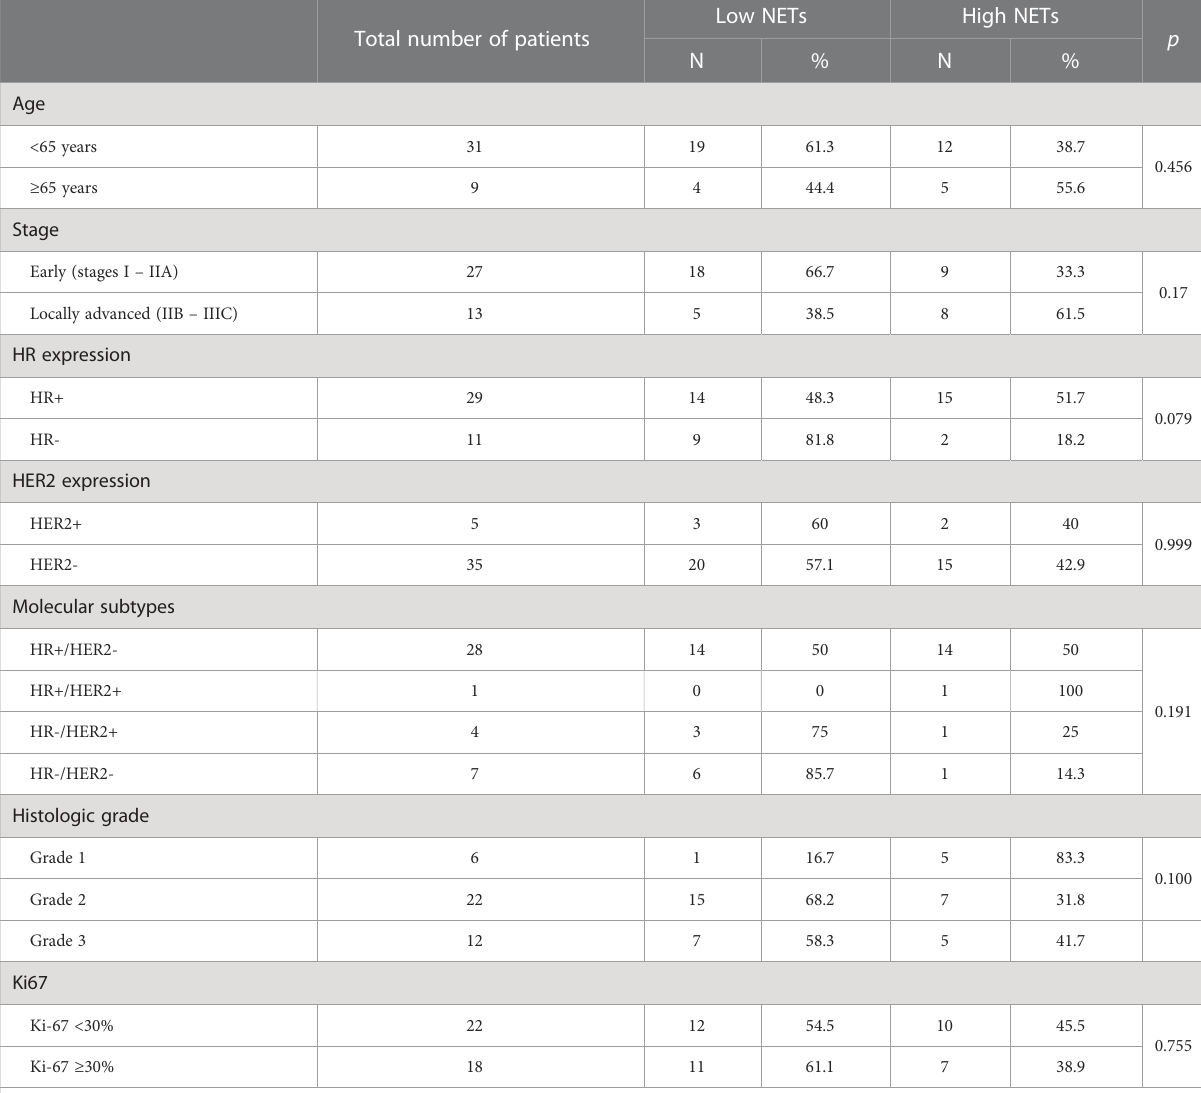
TABLE 2 Associations between clinicopathological characteristics and circulating NETs levels.*